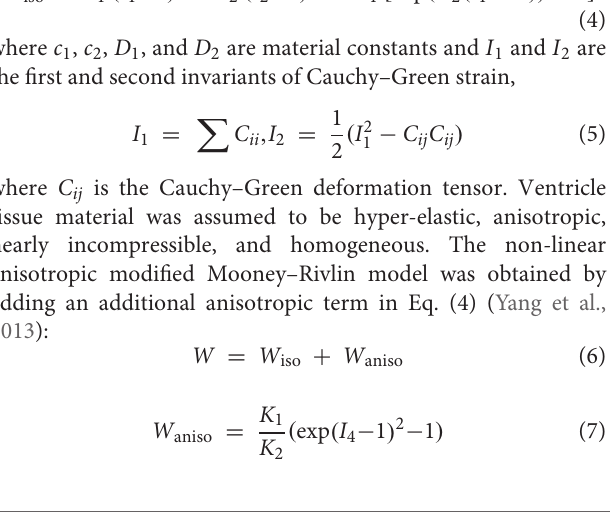
Plan A models are models with a band at anterior to the middle of PM. They are named as AXXX, where A is short for anterior, and XXX represents band active contraction ratio, for example, 010 = 10%. Plan B models are models with a band at posterior to the middle of PM. They are named PXXX, where P is short for posterior. Plan D models has a band at the base of PM. They are called BXXX, where B is short for base. For multiband plans, plan C models are named as APXXX since plan C is the combination of A and B; and Plan E is named as APBXXX because plan E is the combination of A, P, and B. PM, papillary muscle.